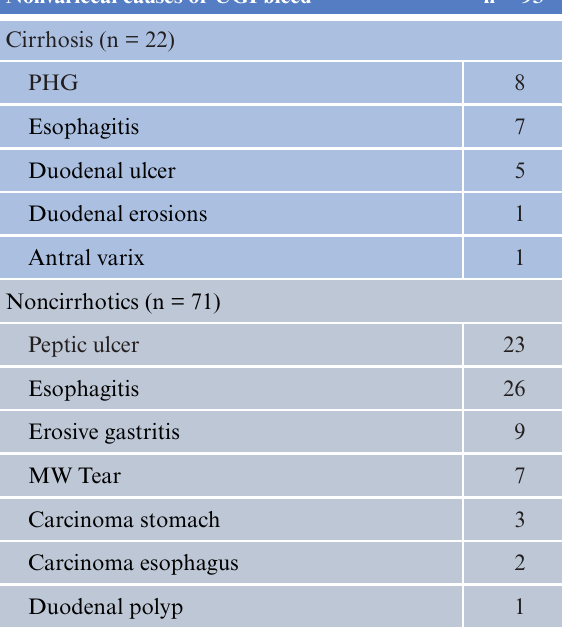
Table 1: Spectrum of upper GI bleed presenting in emergency department in the nonvariceal group (n = 93).